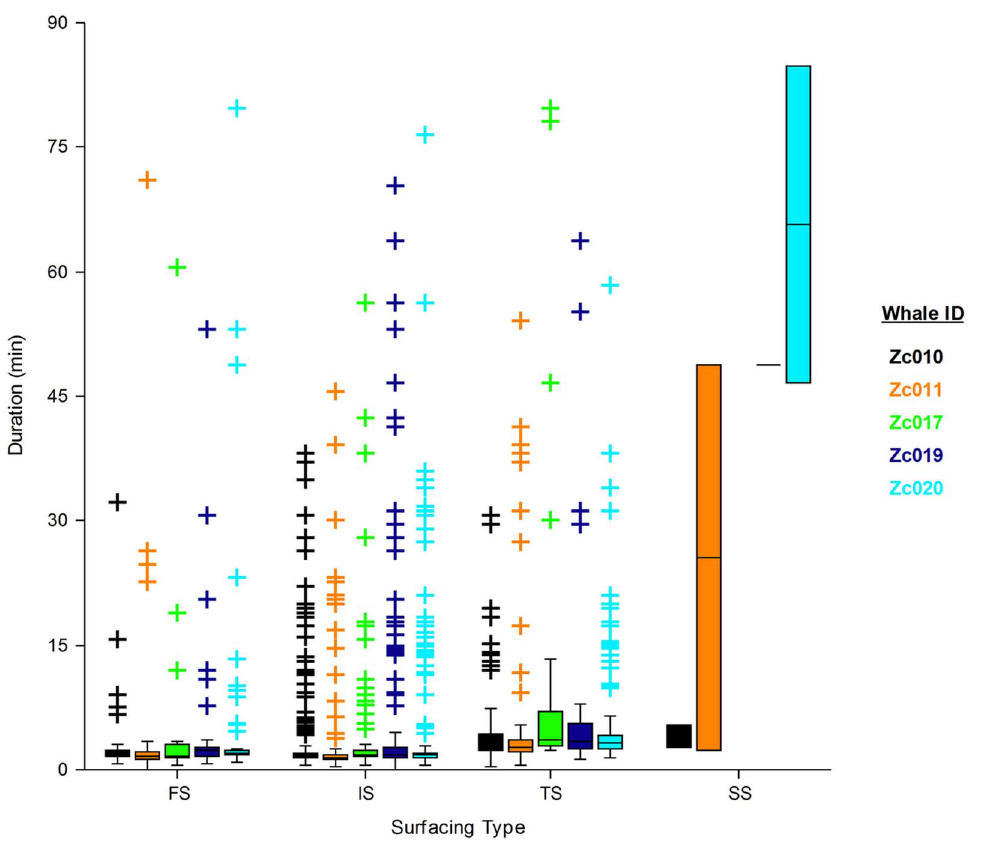
Figure 4. Box plot of surfacing bout duration by surfacing type, by individual. First Surfacing bouts (FS), Intermediate Surfacing bouts (IS), Terminal surfacing bouts (TS), and Single Surfacing bouts between deep dives (SS). Only the five tags using the wet/dry sensor are included (Table 2). Zc019 had only one SS, and Zc017 did not conduct any consecutive deep dives. Boxes represent the median and inter-quartile range, with whiskers at 1.5 times the inter-quartile range. Severe outliers are indicated by plus symbols. Surfacing bouts were typically very short, however occasional severe outliers (representing unusually long surfacing bouts) occurred in all surfacing bout types.